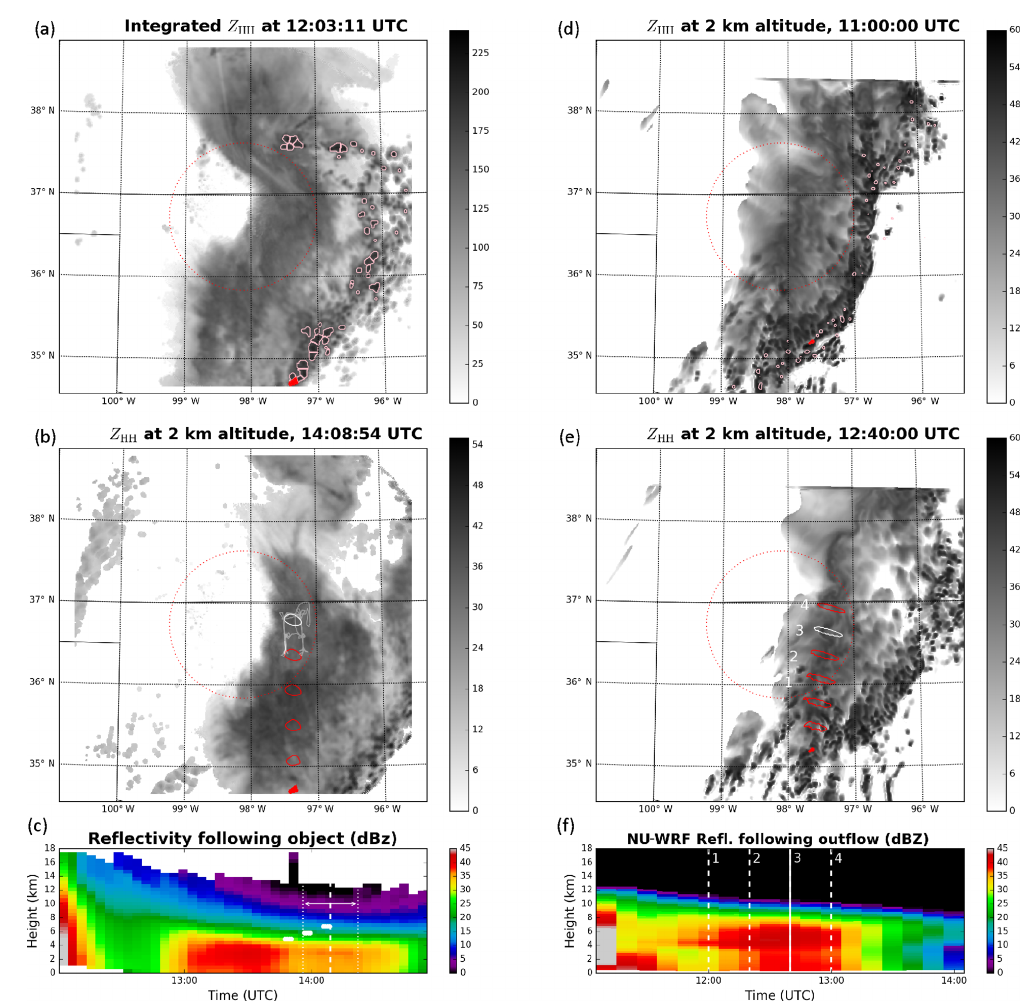
Figure 16. Horizontally polarized radar reflectivity ( Z HH in dBZ) from KVNX radar (dotted red circle): (a) example updraft object at ∼ 12:00UTC (solid red) among others identified in units of dBZ kilometers (red enclosed; see text); (b) movement of example updraft from initial location (solid red) towards intersection with the aircraft sampling location (white enclosed; see text) projected onto 2km Z HH at ∼ 14:00UTC; and (c) Z HH curtain obtained from column-wise averages over tracked regions from ∼ 12:00 to 15:00UTC with Citation ascent legs in time and height (white bars) and averaging time used in Fig. 17 (white lines). From the AERO simulation: (d) identification of a typical updraft object projected onto simulated Z HH at ∼ 11:00UTC (solid red) among others identified (red enclosed; see text); (e) its movement from the identified location (solid red) to the intersection with the aircraft sampling location (white enclosed; see text) projected onto simulated 2km Z HH at ∼ 13:00UTC; and (f) Z HH curtain obtained from column-wise averages over tracked regions from ∼ 11:00 to 14:00UTC with the midpoint of hour-long averages used in Fig. 17 (white